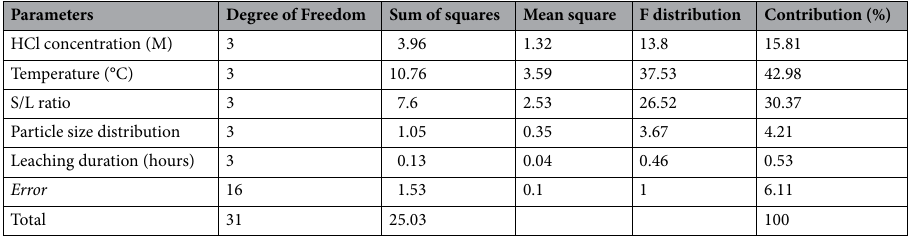
Table 6. Result of the analysis of variance for the dissolution of iron.